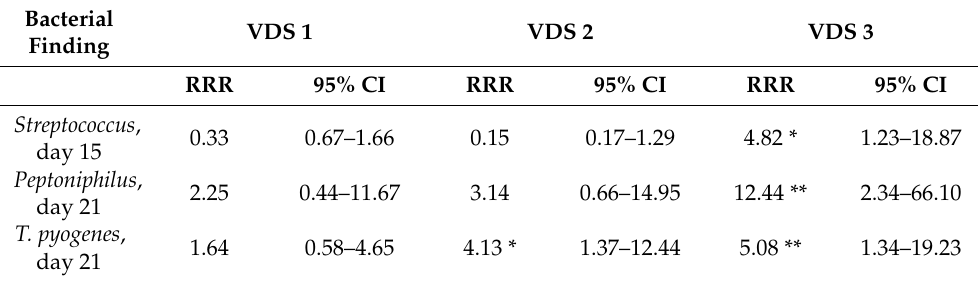
Table 1. Relative risk ratio and confidence intervals for vaginal discharge score (VDS) 1, 2, and 3 (in comparison to VDS 0) as assessed on day 21 postpartum in relation to the bacterial findings of T. pyogenes , E. coli , Streptococcus spp., and Peptoniphilus spp. on days 0, 3, 9, 15, and 21 postpartum as calculated by multinomial logistic regression. Only days with significant results are